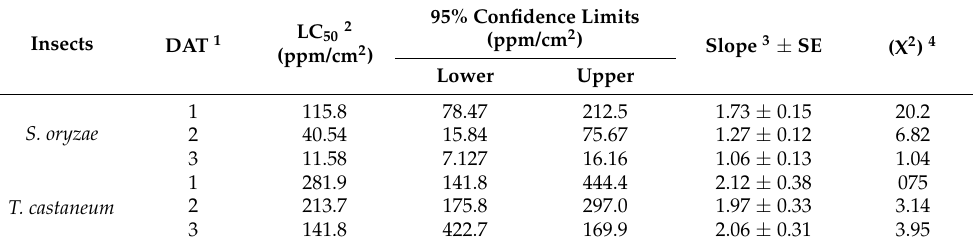
Table 5. The LC 50 values of R. officinalis oil recorded against S. oryzae and T. castaneum adults following